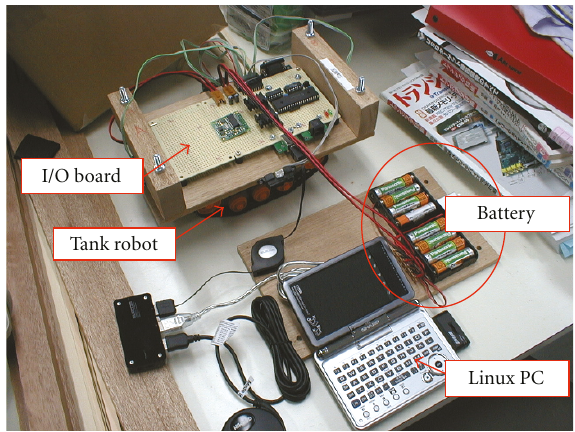
Figure 17: Photograph of an outdoor